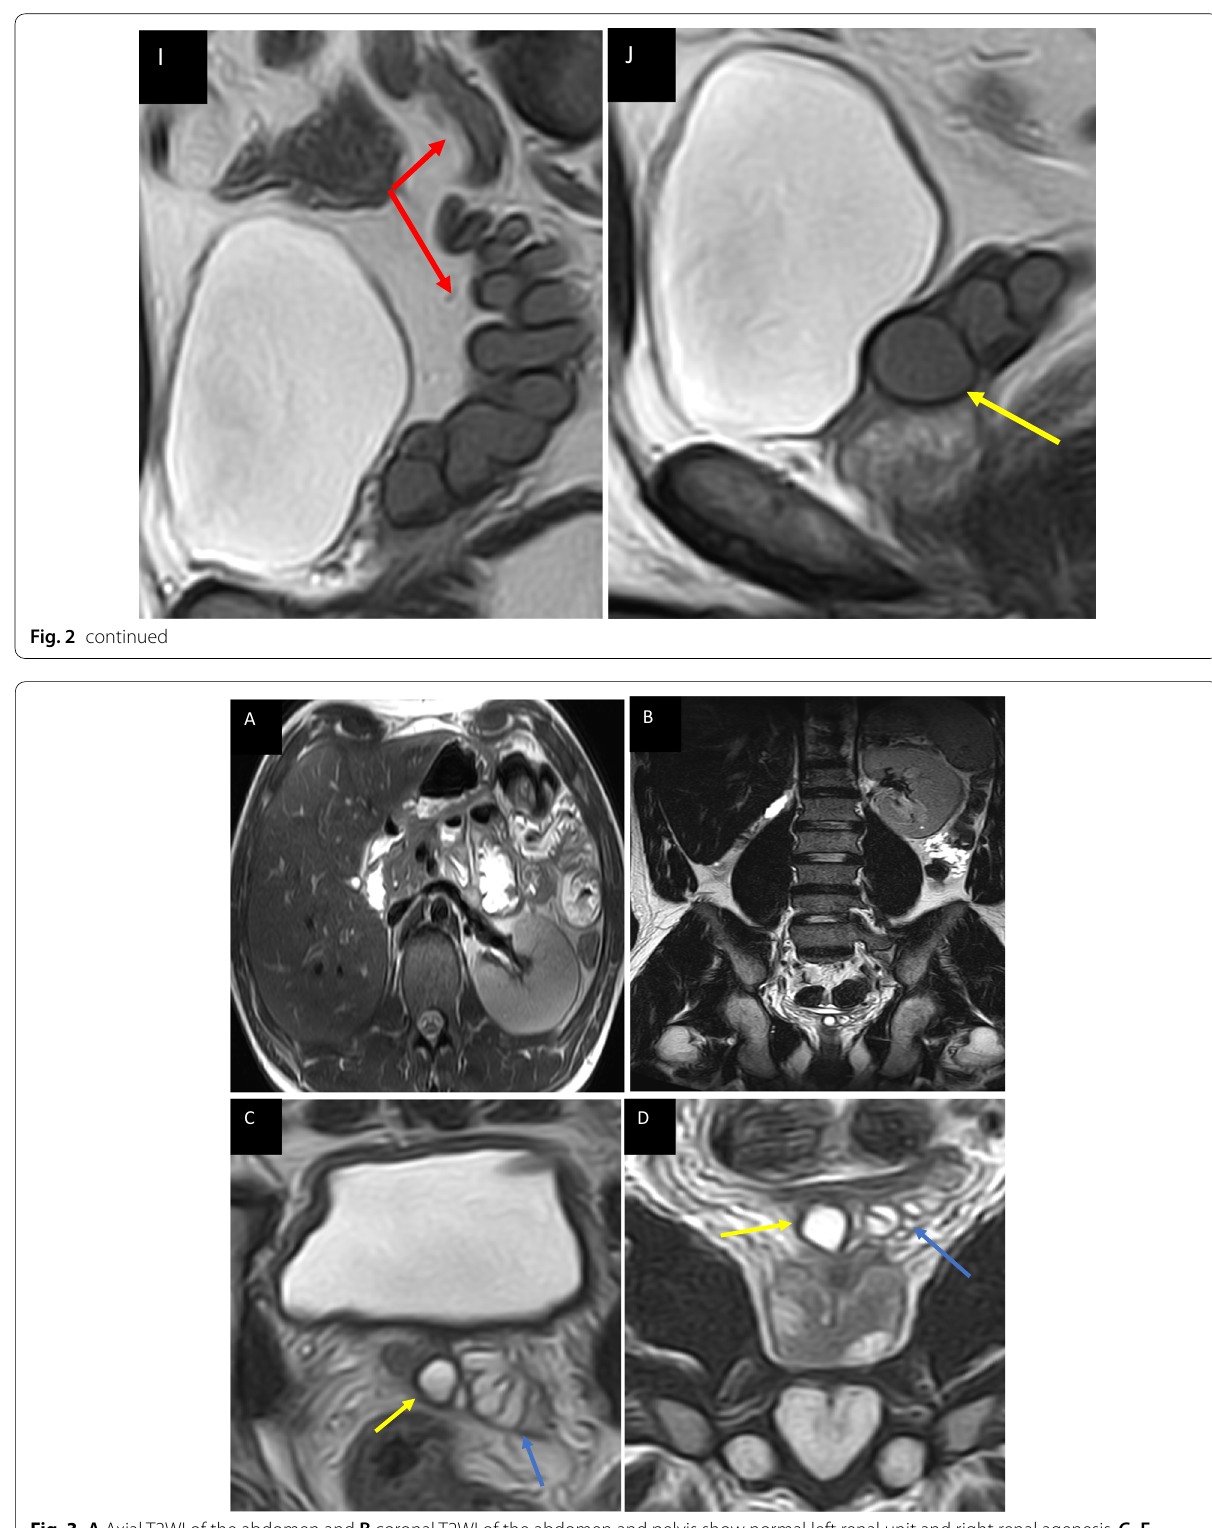
Fig. 3 A Axial T2WI of the abdomen and B coronal T2WI of the abdomen and pelvis show normal left renal unit and right renal agenesis, C – F high‑resolution axial, coronal and right parasagittal T2WI of the pelvis revealed normal left SV (blue arrow) and right SV cyst (yellow arrow) measured (1.7 1.3 cm). It displays high T2WSI and low T1WSI (not shown) denoting clear fluid content, as well as ED obstruction (White ×